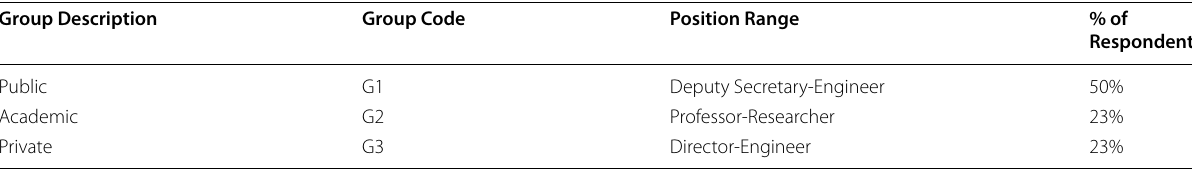
Table 2 Notation for respondent groups Group